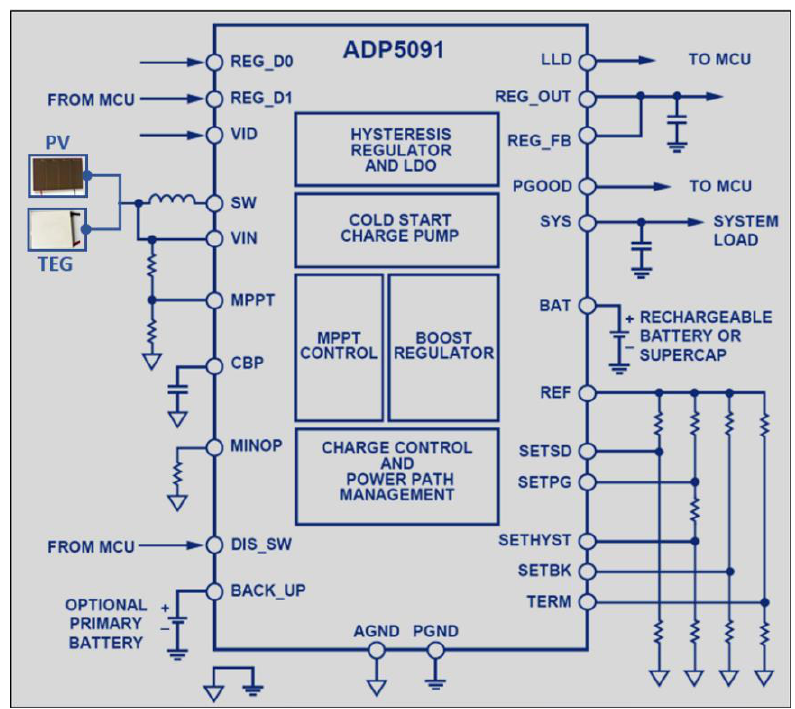
Figure 7. Typical application circuit of ADP5091 EH Module [50].